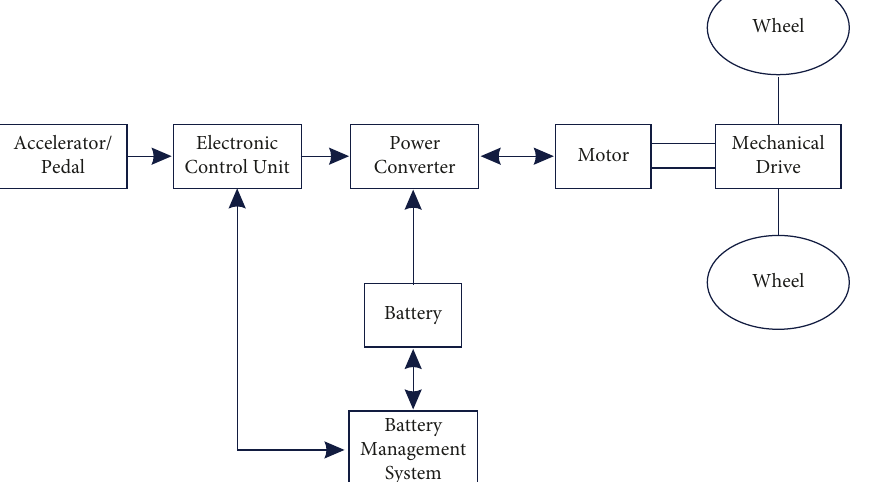
Figure 1: Block diagram of BMS in EV.